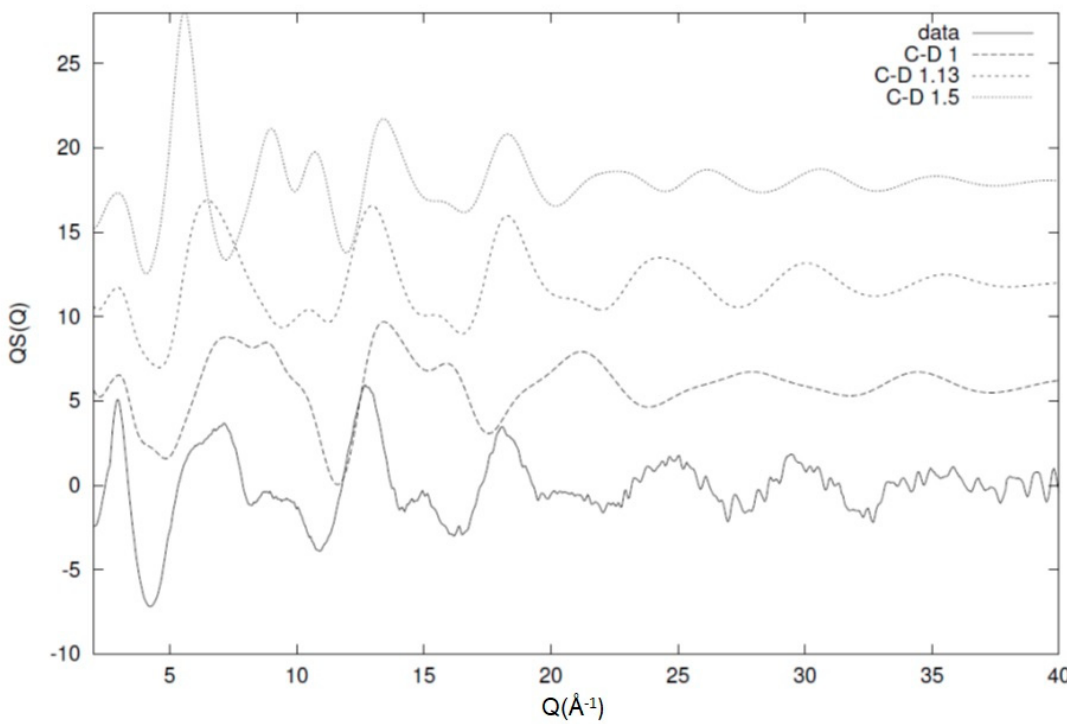
Figure 13. Effect of the carbon–deuterium bond on the overall picture of the diffraction pattern. The best-fit distance of 1.13 Å (short-dashed line) shows a significant resemblance to the experimental data (solid line) when compared with two artificial C-D values of 1 Å (dotted line) and 1.5 Å (short dashed line). All the curves have been shifted for clarity. The image has been reproduced with permission from Reference [6] © American Chemical Society.